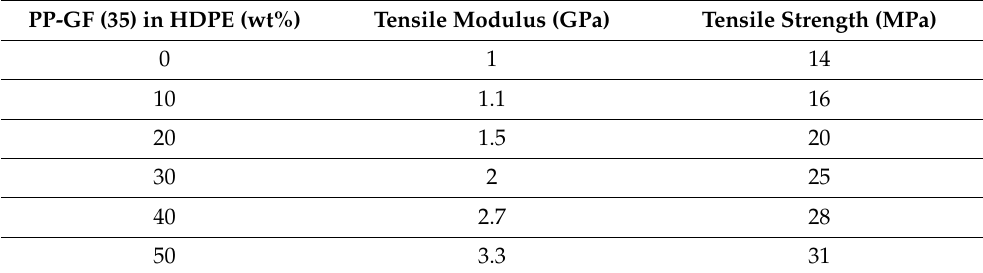
Table 3. Mechanical properties of recycled HDPE composite with PP-GF (35) [29–31]. PP-GF (35) in HDPE (wt%) Tensile Modulus (GPa) Tensile Strength (MPa)